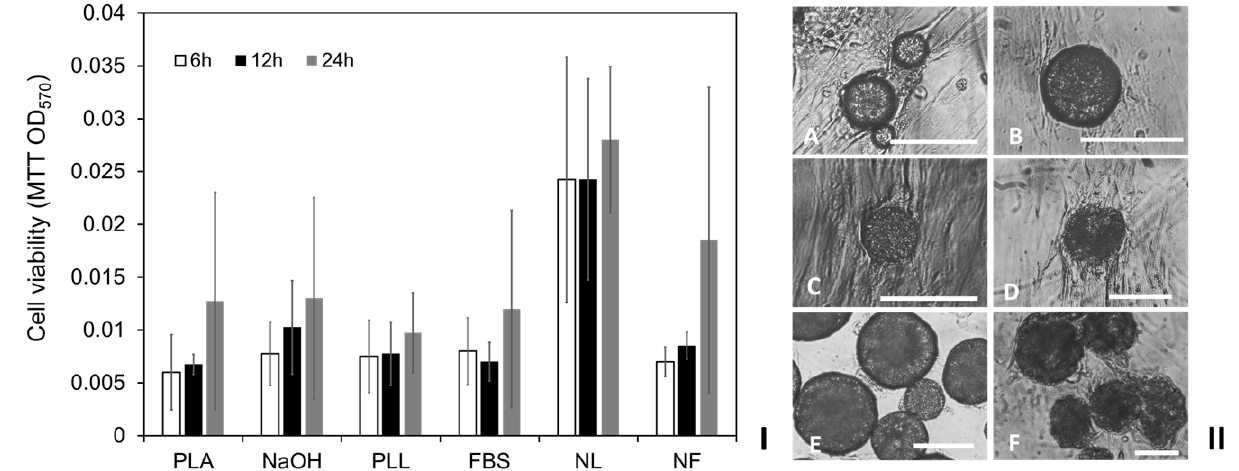
Figure 5. Influences of PLA particle surface modifications on modular tissue cultures. ( I ) MTT via- bility assay (OD 570 ) of HDFs seeded and cultured for 6, 12 and 24 h on PLA particles modified using different methods: PLA: not-treated PLA particle control, NaOH: hydrolysis in 0.5 M sodium hy- droxide (NaOH), PLL: coated with poly-L-lysine (PLL); FBS: coated with fetal bovine serum (FBS), NL: PLL coating after NaOH hydrolysis; NF: FBS coating after NaOH hydrolysis. Results shown are mean ± SD ( n = 3 independent experiments). ( II ) Micrographs of the HDFs cultured in each well of 24-well tissue culture plates with PLA particles modified using different methods: ( A ) PLA, ( B ) FBS, ( C ) PLL, ( D ) NaOH, ( E ) NF, ( F ) NL. Scale bar = 100 µm.